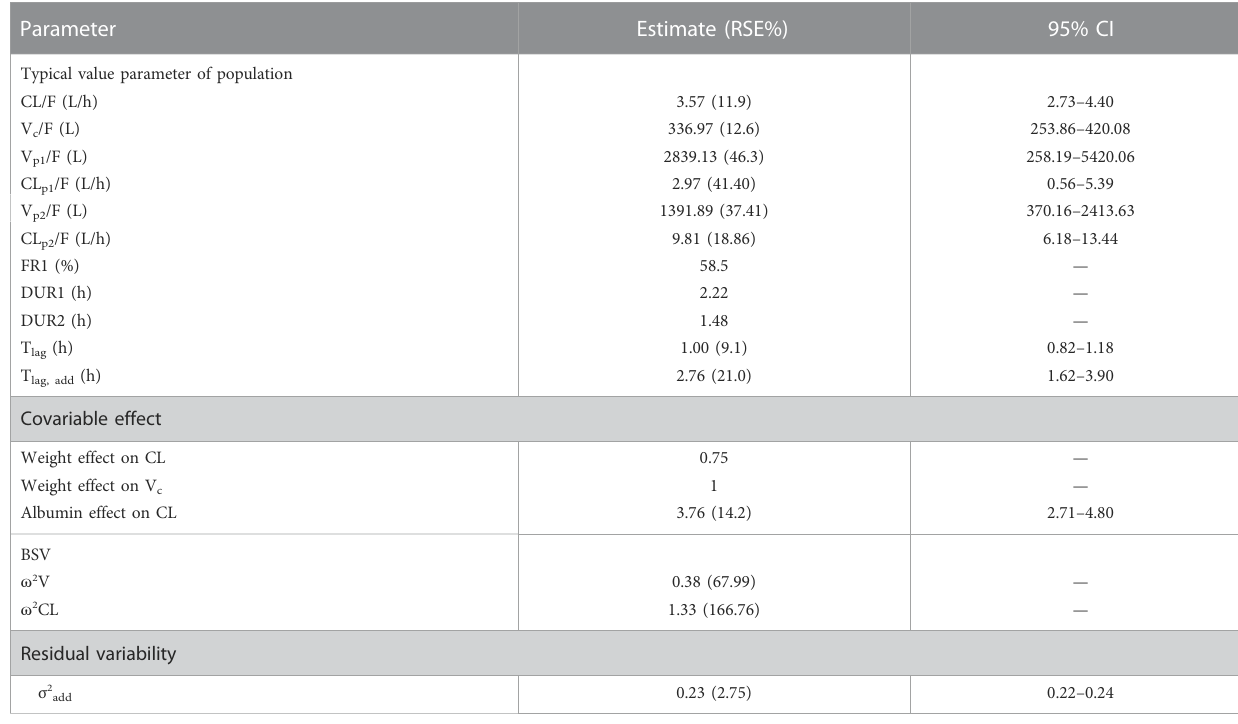
TABLE 2 Pharmacokinetics parameter estimations of the development cohort.